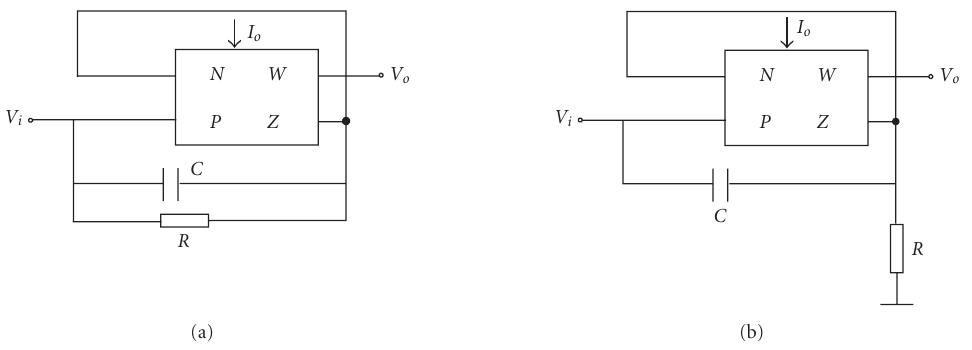
Figure 3: (a) Proposed all-pass filter Circuit-1 using CCCDBA and (b) proposed all-pass filter Circuit-2 using